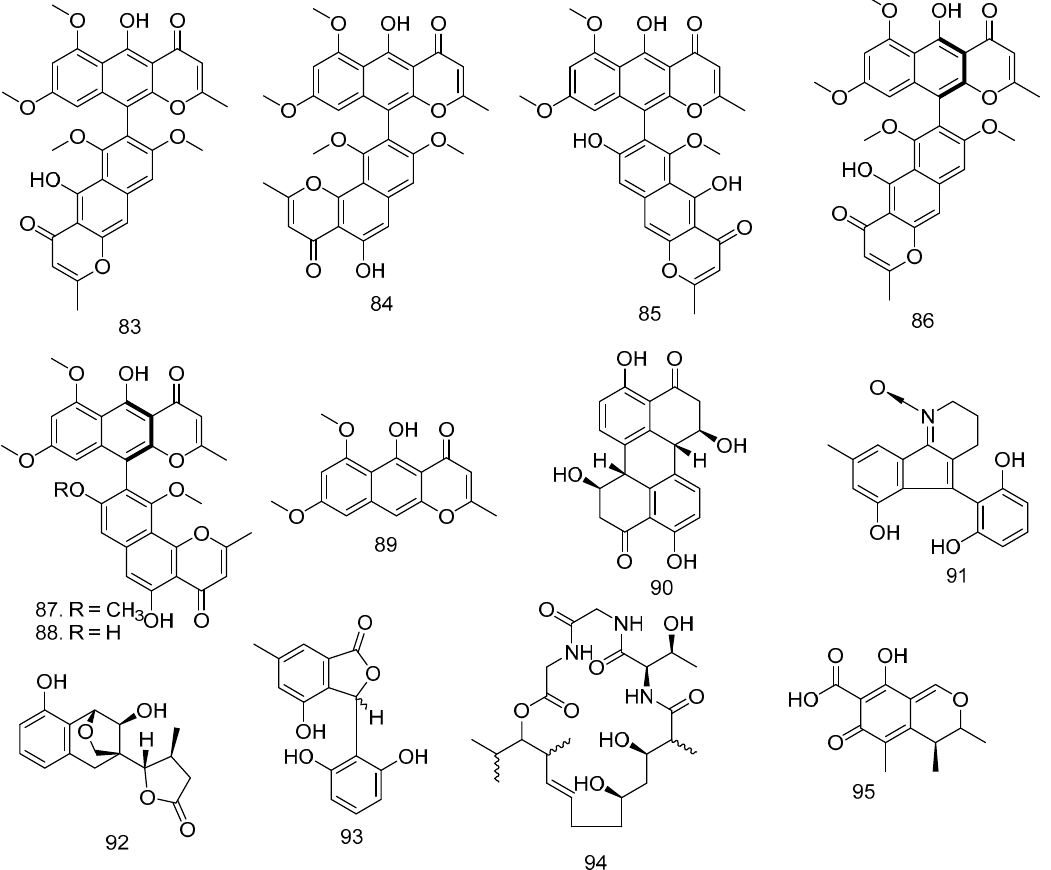
Figure 4. The compounds of polyketides obtained from various fungi in the Meliaceae Family.